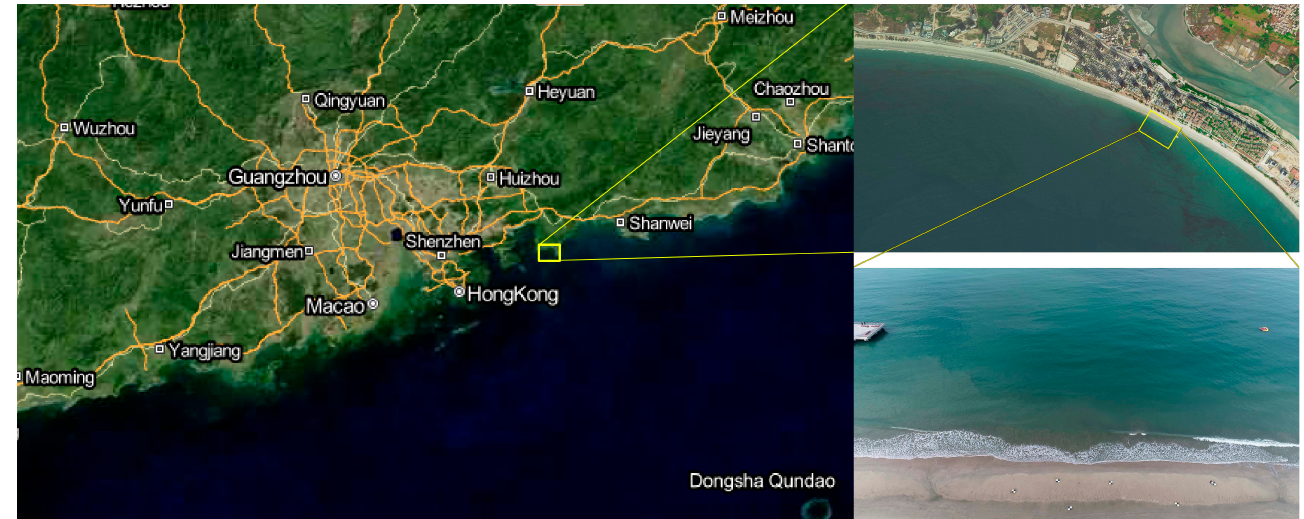
Figure 1. Shuang Yue Bay satellite map and image.